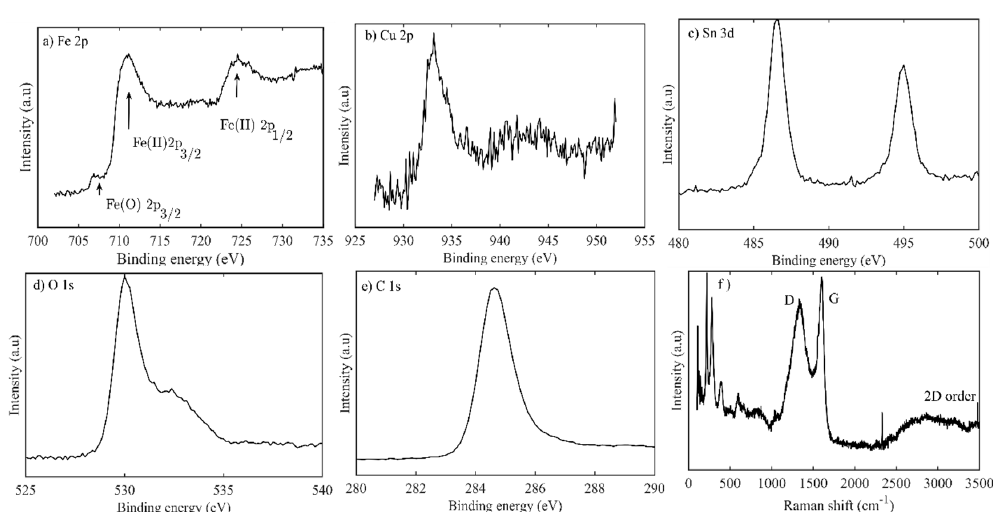
Figure 3. TEM images of CuSn ( a ) and Sn ( b ).